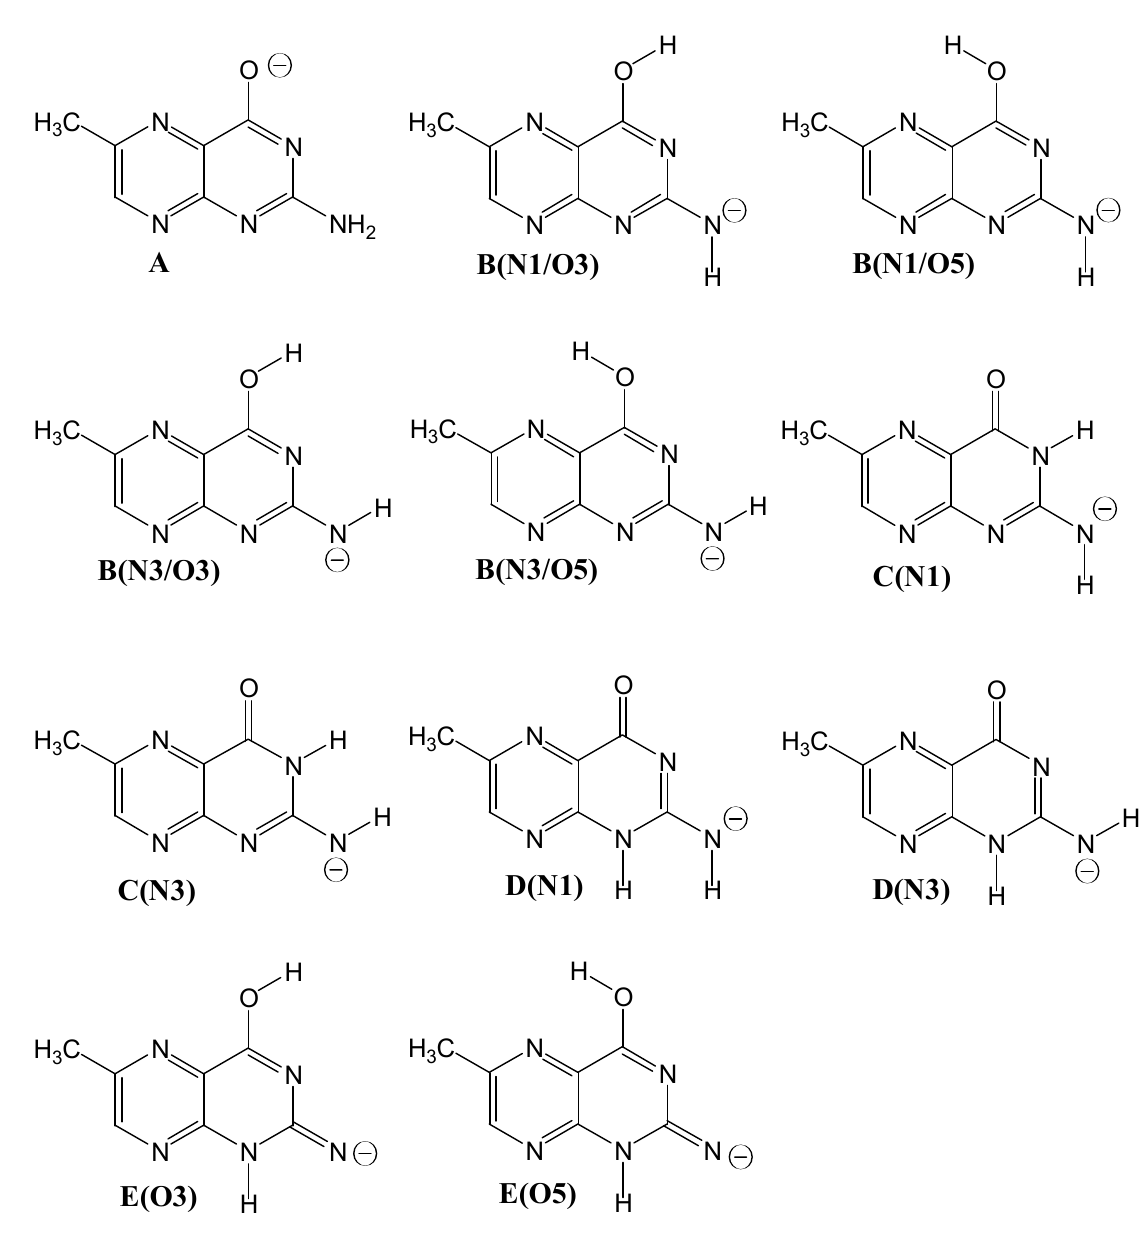
Figure 3. Anionic form of pterin